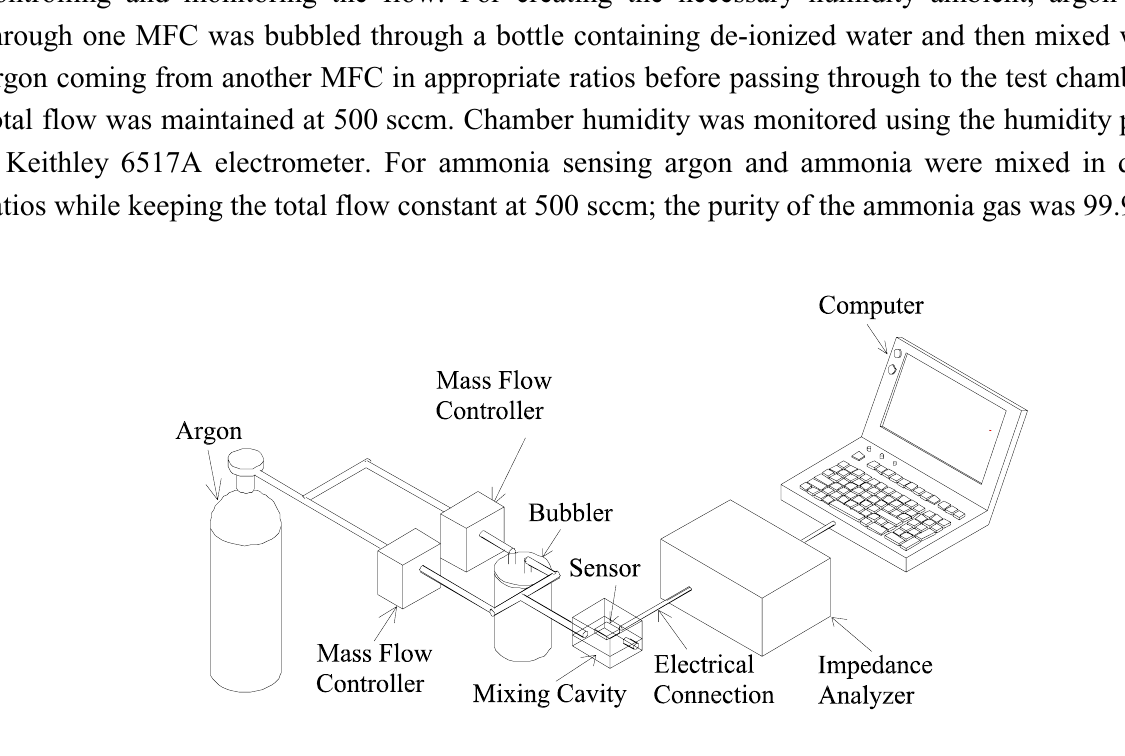
Figure 2. Schematic diagram of the experimental set